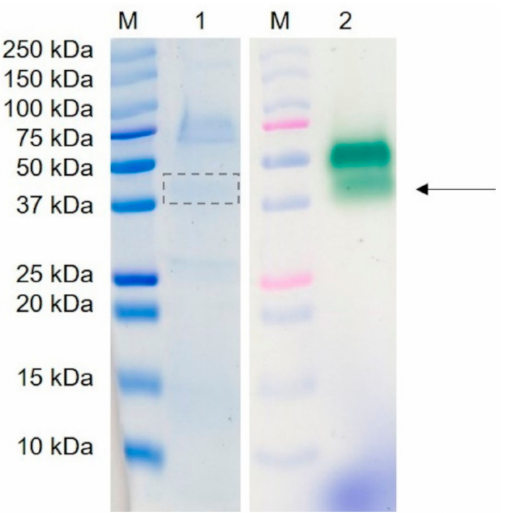
Figure 2. Semi-native PAGE of the active fraction after purification of the alkene cleavage enzyme from P. sapidus by IEX. 1: gel stained with Coomassie Brilliant Blue; 2: gel stained with ABTS in the presence of hydrogen peroxide, M: pre-stained molecular mass marker. An arrow and a box marks the protein that was successfully identified by